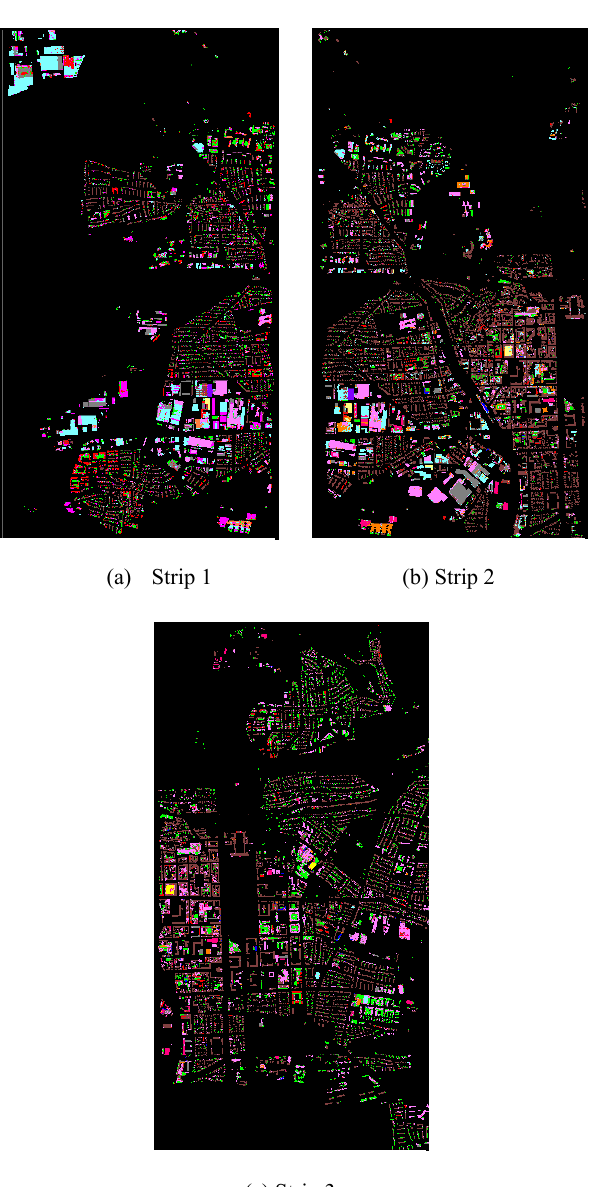
Figure 4: Classification results of the strips covering the research